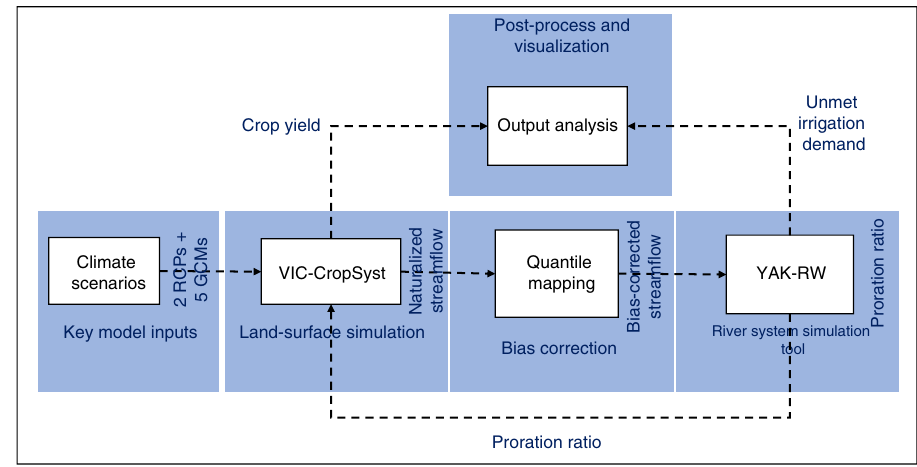
Fig. 4 Simulation platform used in this study. Projected changes were attained using a tightly coupled agro-hydrologic land-surface model (VIC- CropSyst), quantile mapping-based bias correction, and the YAK-RW river system simulation. In this fi gure, dashed arrows indicate of fl ine transfer of information between different components of the modeling